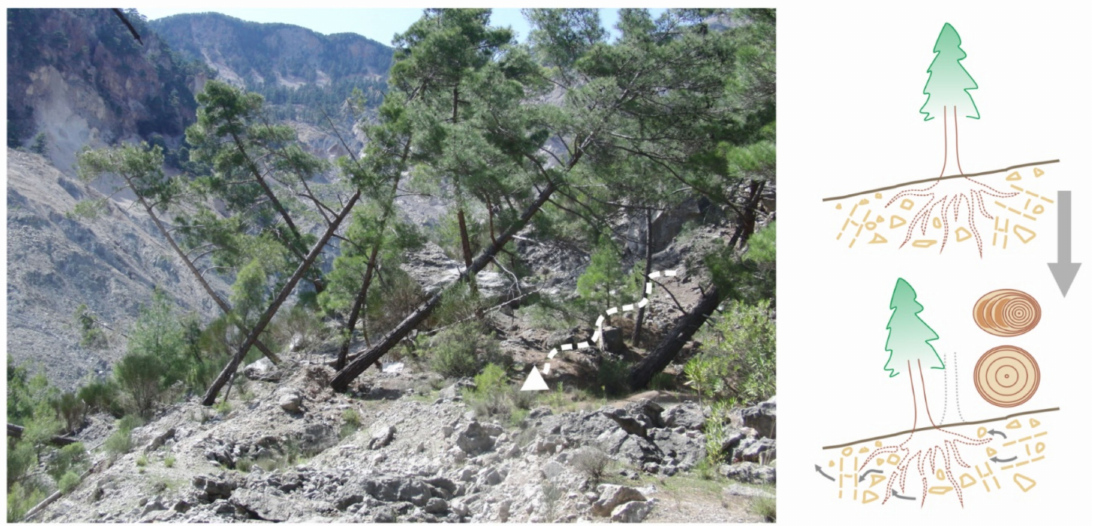
Figure 7. The effect of flow-like landslide movements to tree growth.